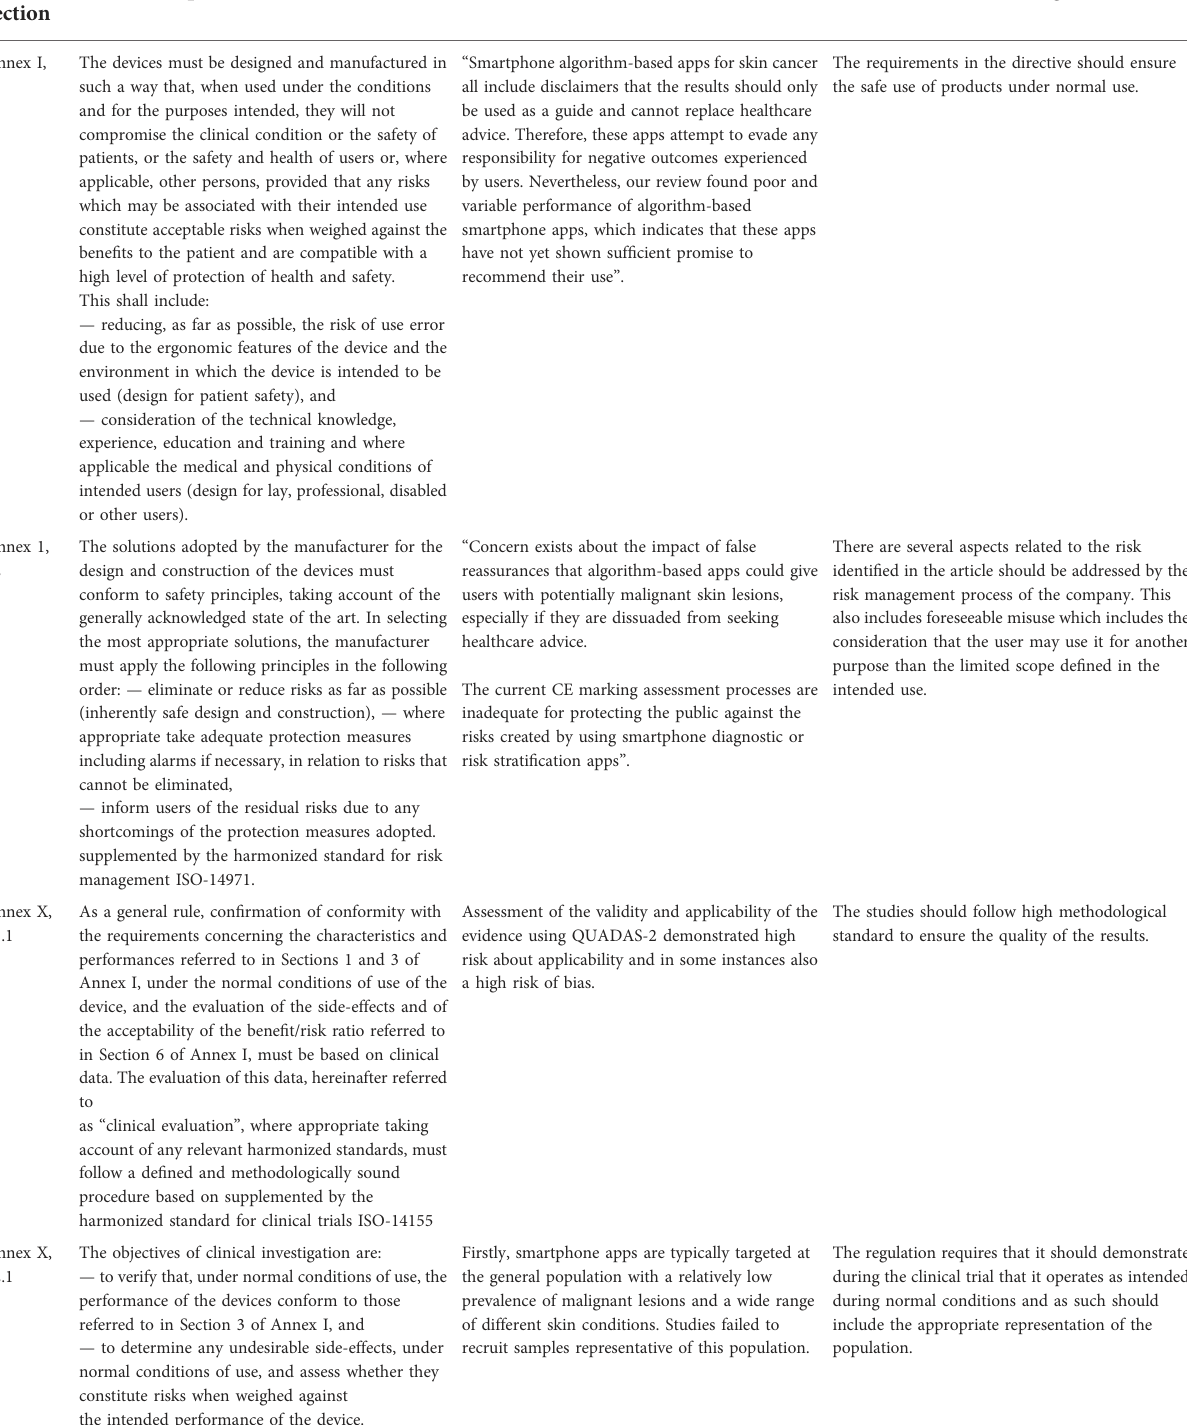
TABLE 1 Comparison of DHS quality issues identi fi ed in the Freeman et al. (1) systematic review vs. regulatory requirements in the